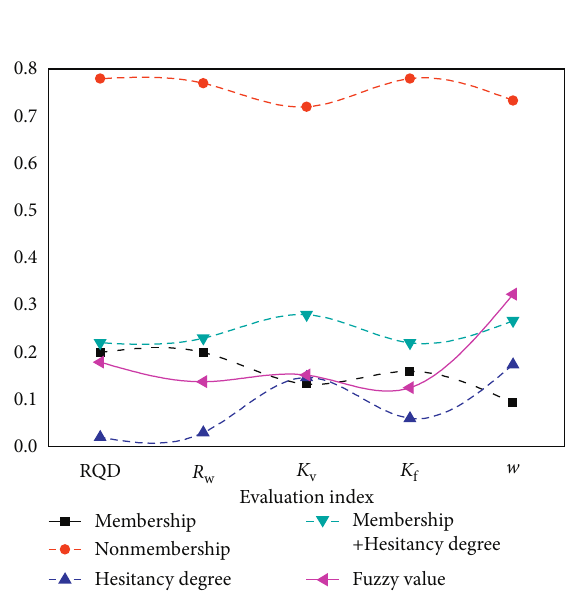
Figure 7: The relationship between weight and fuzzy